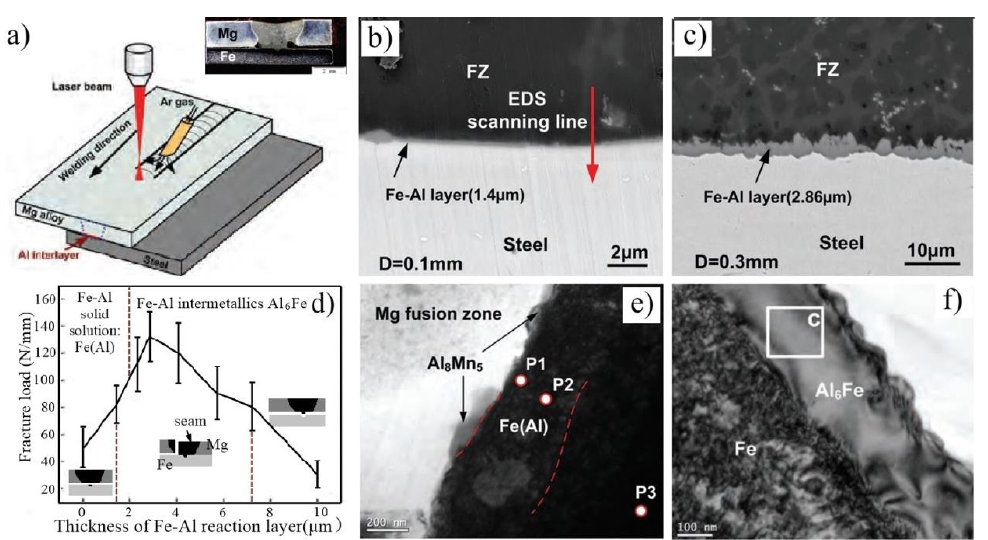
Figure 14. Laser-welding process of Mg to steel with the Al interlayer [44] ( a ) schematic diagram; ( b , c ) microstructure morphologies of interfacial reaction layers with 0.1 and 0.3 mm Al interlayer; ( d ) fracture load with a function of the thickness of the reaction layer; ( e , f ) TEM micrograph for reaction layer below/above 2 μm.